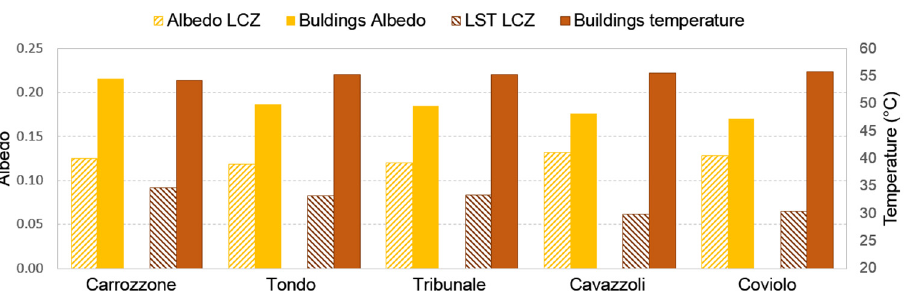
Figure 7. Albedo values for each LCZ and its buildings; LST values for each LCZ and its buildings.